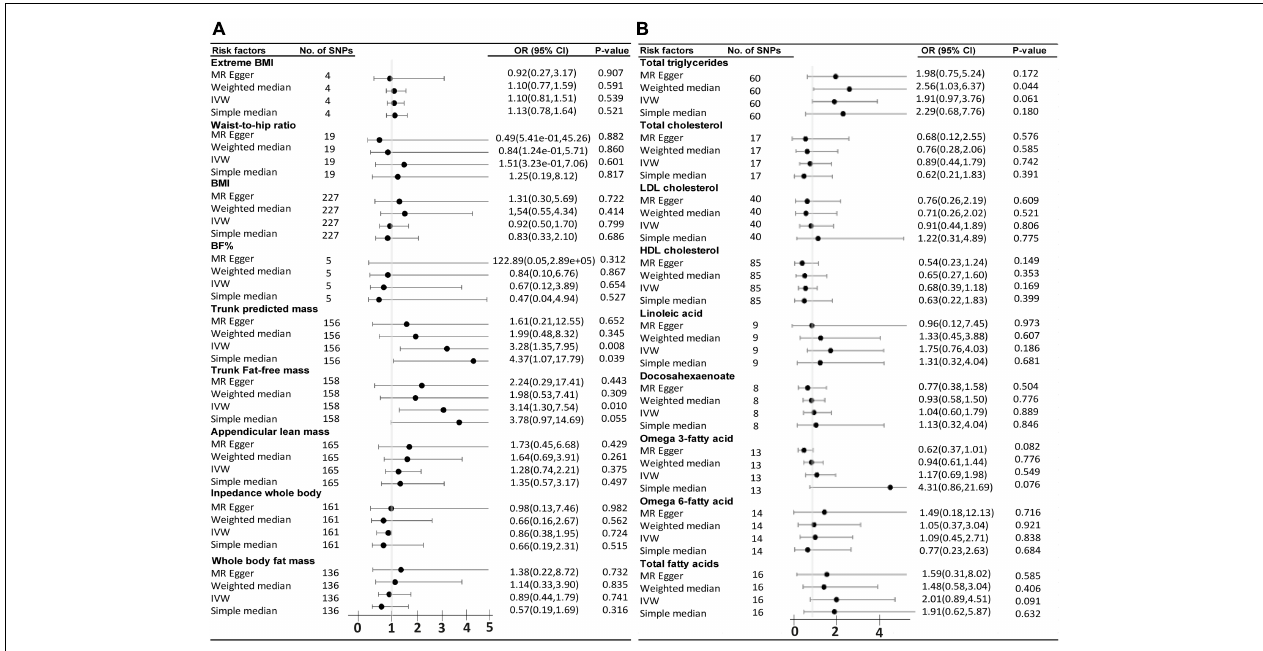
FIGURE 3 | Odds ratio (OR) and forest plot for the causal association with the risk of frontotemporal dementia with TDP43 aggregates by, (A) Body complexion traits, and (B) Circulating lipids traits. BMI, body mass index; BF%, body fat percentage; CI, confidence interval; IVW, inverse variance weighted; SNPs, single nucleotide